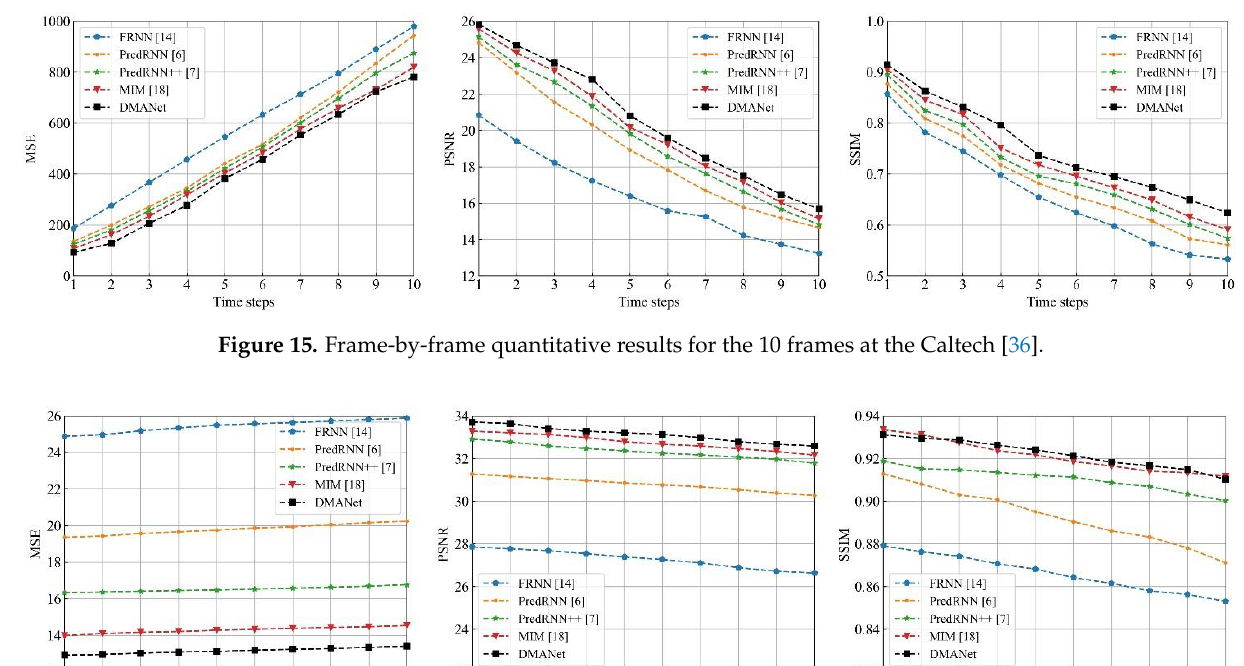
Figure 16. Frame-by-frame quantitative results for the 10 frames at the AR Map.